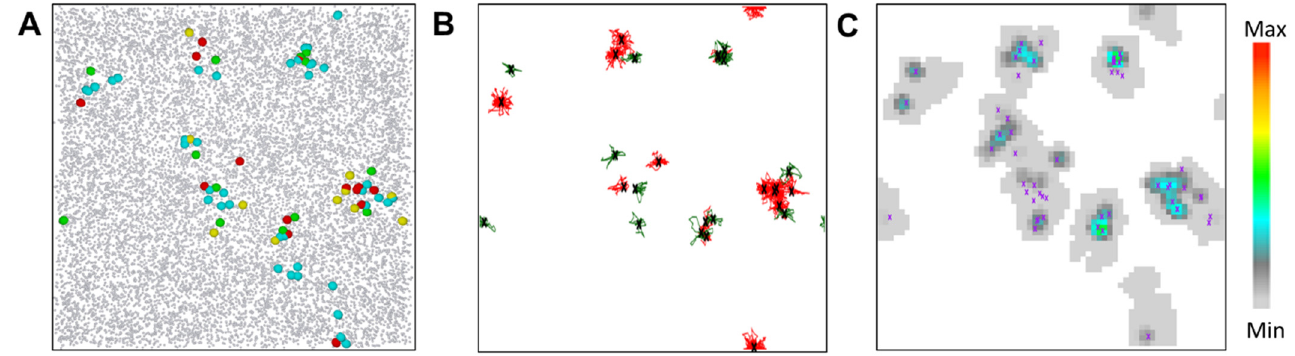
Figure 1. Agent properties. ( A ) The spatial distribution of agents (16,000 agents) at t 1 = 4 weeks. Color encodes the type of agent. Grey: S , yellow: E , red: I s , green: I a , cyan: R . The size of agents in state E , I s , I a and R is enhanced for better identification. ( B ) The traces of agents during their infectious state, and ( C ) the viral load V L induced by these agents. Small crosses indicate the agent’s base position. For the duration of the exposed state, T E = 1/ α , we assume two days [23]. In contrast